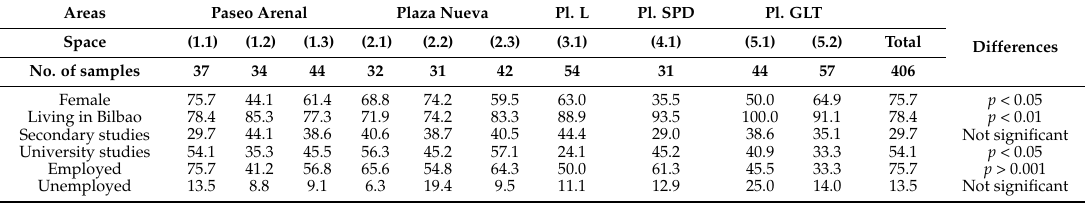
Table 2. Characteristics of the participants in the ten places studied in Bilbao (in terms of percentage). Areas Paseo Arenal Plaza Nueva Pl. L Pl. SPD Pl. GLT DifferencesSpace